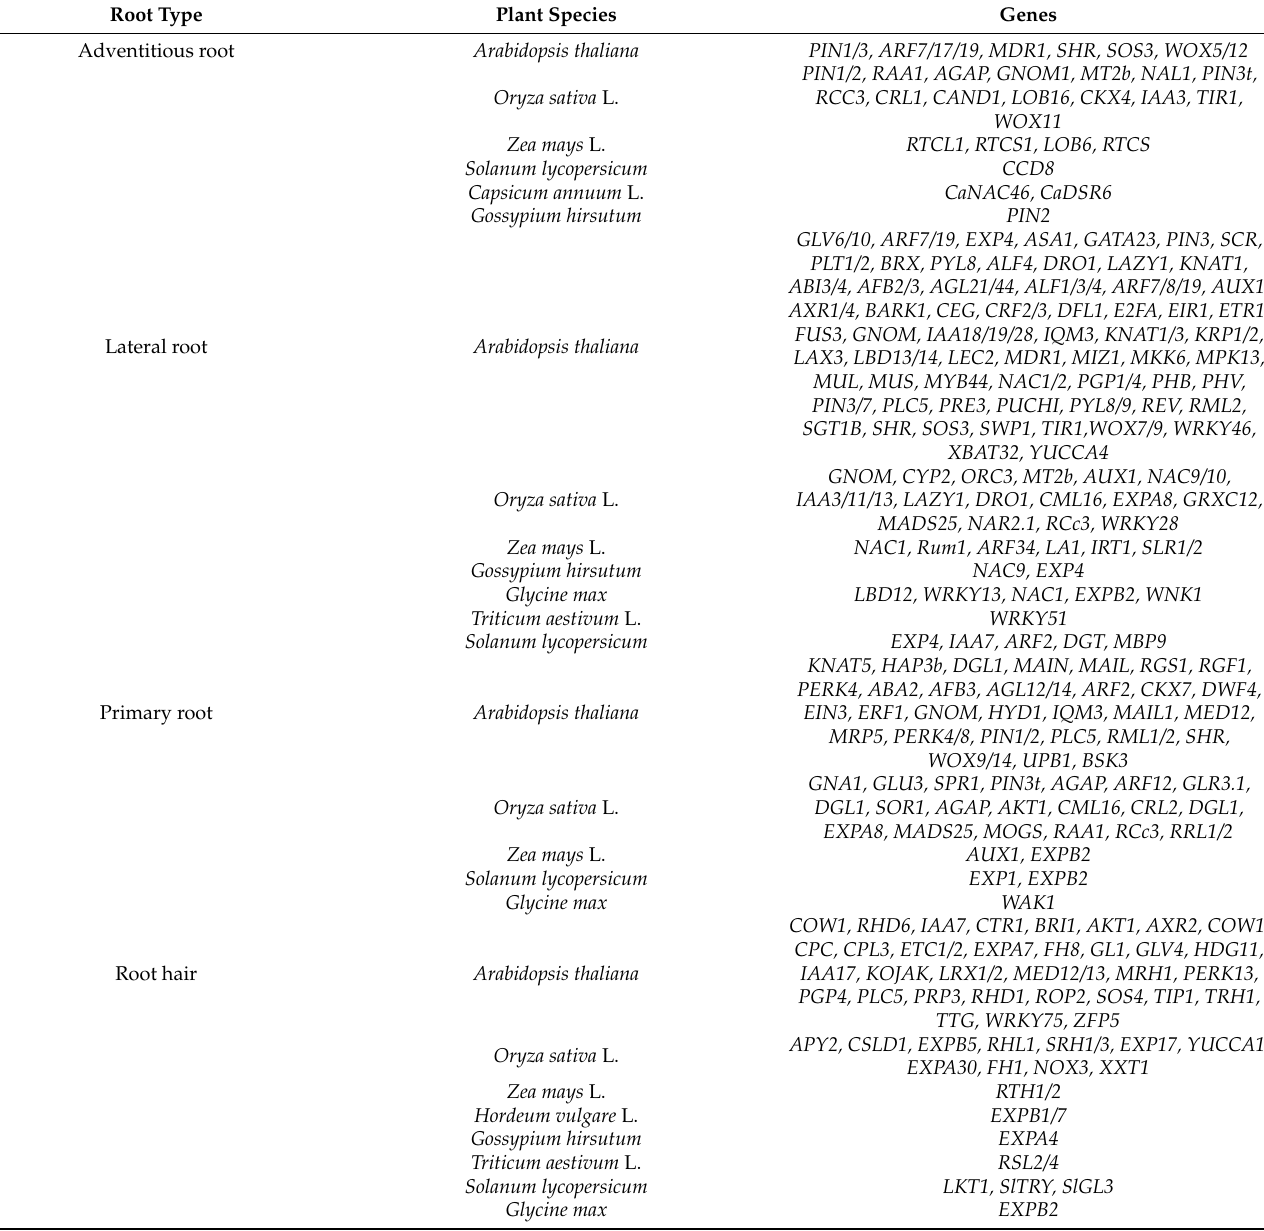
Table 1. Genes related to the development of different parts of plant